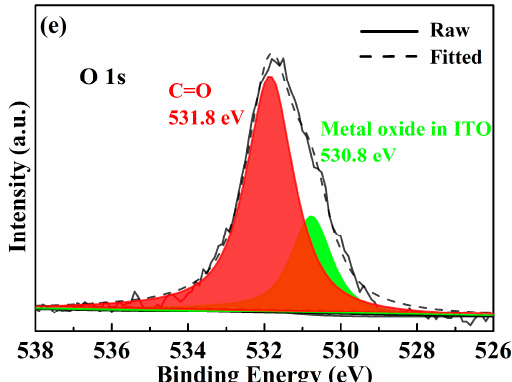
Figure 2. High-resolution X-ray photoelectron spectroscopy (XPS) spectra of the chemical-polymerized copolymer PITID-2 thin films: ( a ) Survey, ( b ) C 1s, ( c ) N 1s, ( d ) S 2p, ( e ) O 1s. The raw curve and the fitted curve were shown in solid and dotted lines, respectively.